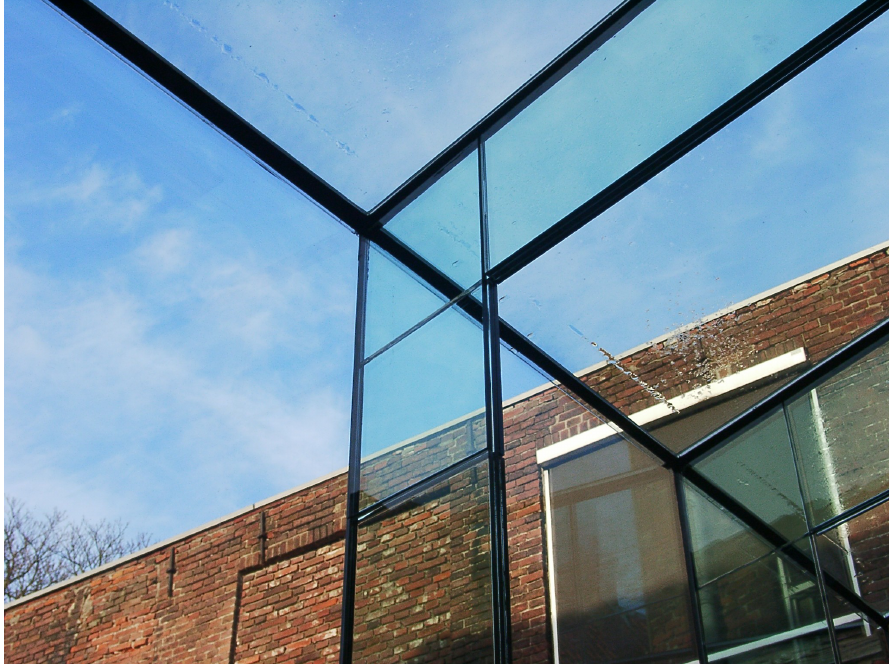
Figure 2: The all glass, glued corner detail, meeting of fin and beam for the Leiden Conservatory, see [2]. Here the meeting of a glass façade fin and a glass roof beam was made by a glued connection. And it still holds after, now, 5 years. But municipality officials (to approve of the building) and the insurance companies have great difficulty in accepting glued connections. The question asked is always; Will it still hold after 100 years? And can you guarantee this? Since no decent answer can be given to this, mechanical connections are essential for the approving (and the safety….) of glass structures. So the following elements were selected to compose the all, well as all as possible, Haarlem Glass Cube. For the roof six glass panels supported by beams that rest on the glass fins in the façade. For each of the for walls or facades of the cube, again, six glass panels, standing on top of each other for gravity and supported by glass fins for the wind. In figure 3 the overall structure of the Haarlem Glass Cube is sketched. The glass cube will be constructed in from March to May